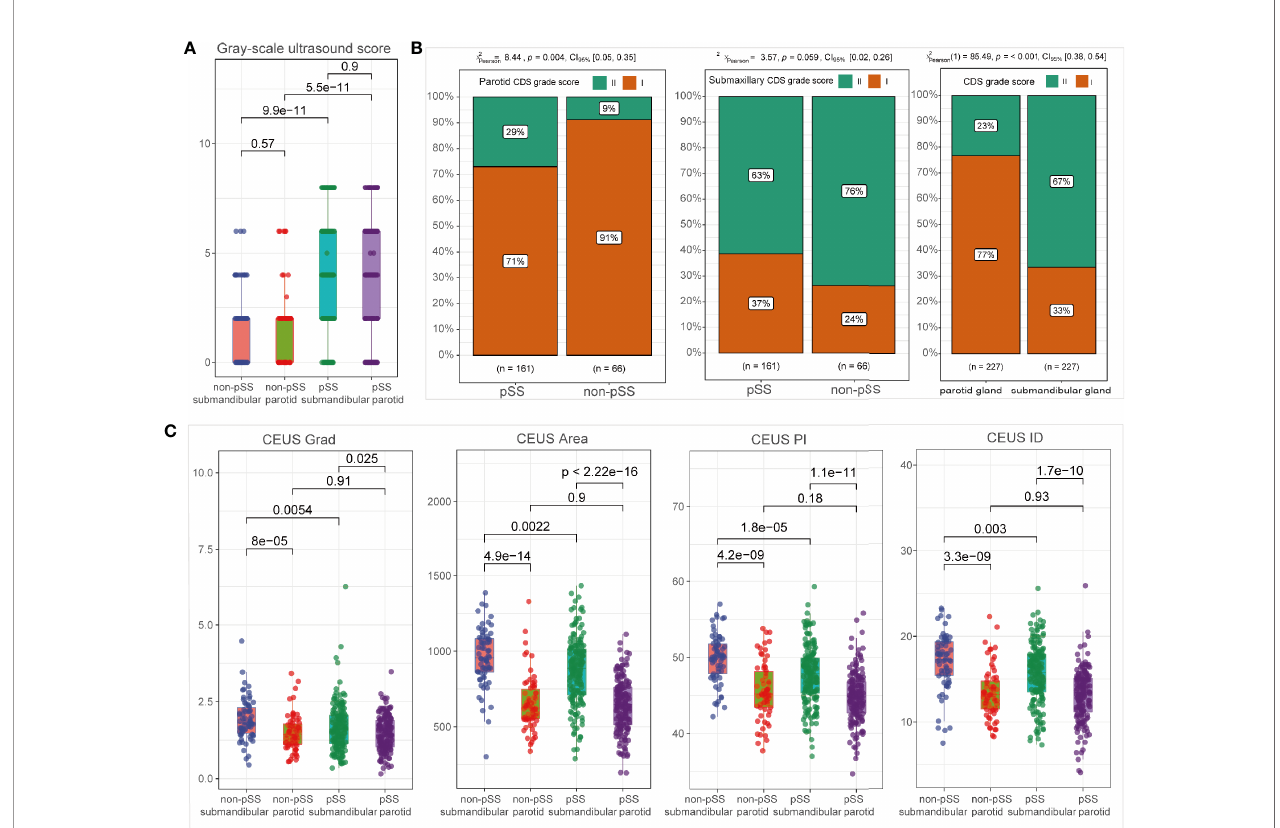
FIGURE 3 | Ultrasonographic abnormalities in the salivary glands of primary Sjögren ’ s syndrome (pSS). Comparison of grayscale ultrasound (US) scores (A) ; CDS grade scores (B) ; and CEUS parameters (C) between subgroups, including pSS vs . non-pSS and parotid vs . submandibular